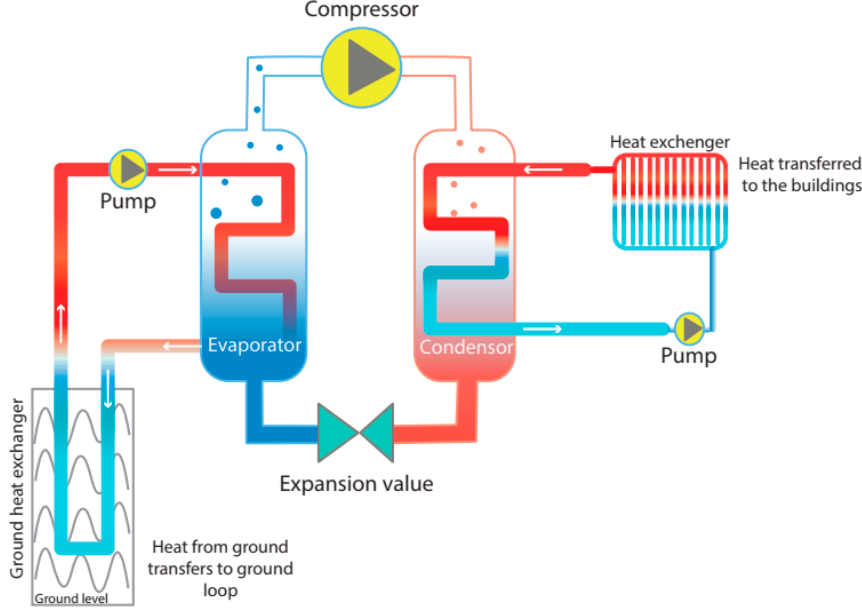
Figure 3. Schematic of a ground source heat pump for district heating.